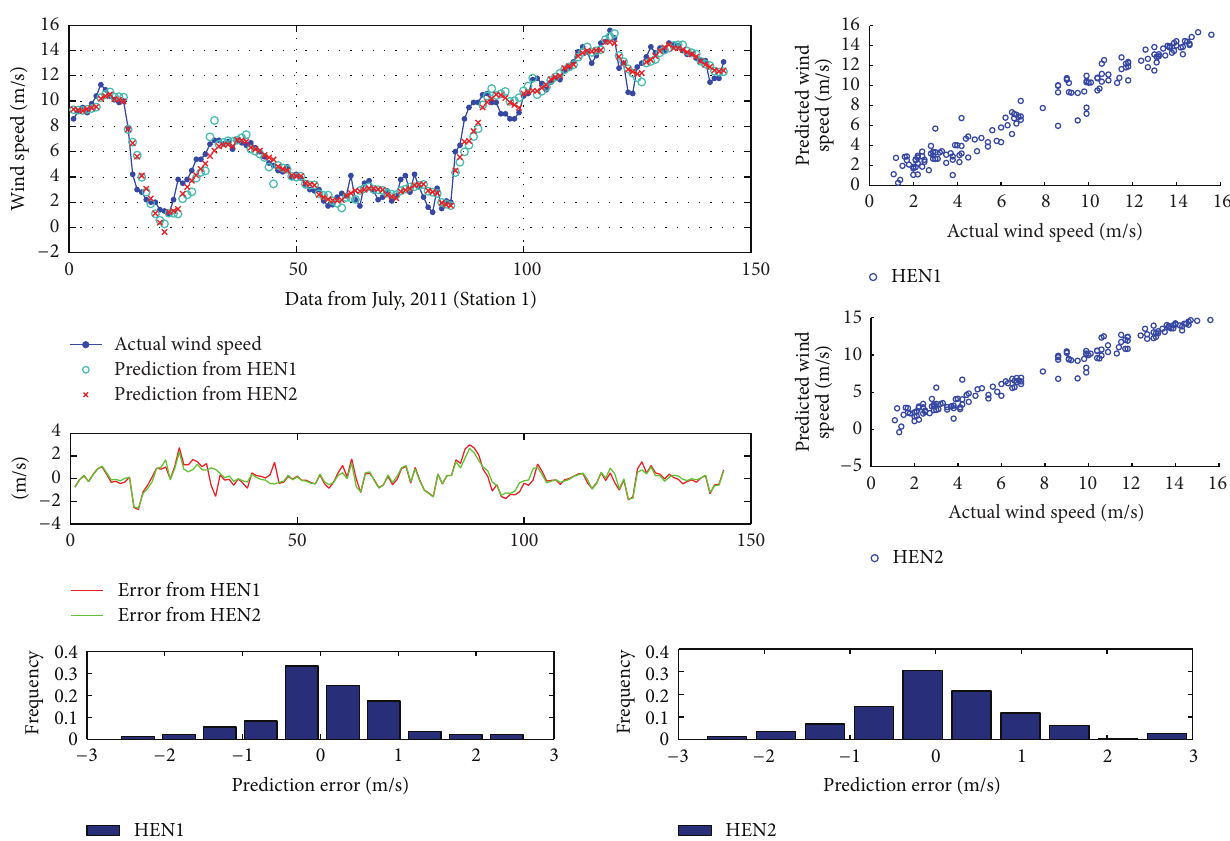
Figure 7: The forecasting results from both proposed hybrid models, exemplified by data from July 2011 at Station